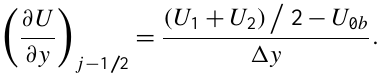
Figure A1. Triangular central-difference integration grid used in the reconstruction (modified from Fig. A1 of SH11). The x axis is halfway between the paths of Sc-A and Sc-B, and points into the figure plane. Numbers on the grid points indicate the order in which data at them are calculated. See text for details about the methods used to reduce numerical errors in estimating the